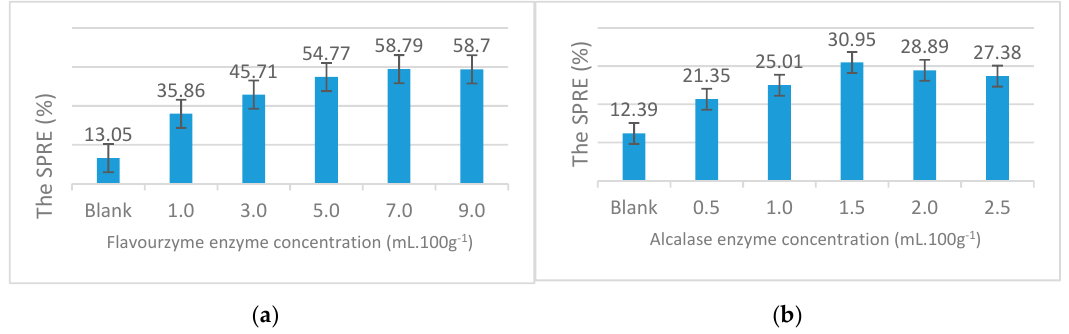
Figure 9. The effect of enzyme content on the SPRE ( a ) Flavourzyme. ( b ) Alcalase. Figure 9. The e ff ect of enzyme content on the SPRE ( a ) Flavourzyme. ( b )